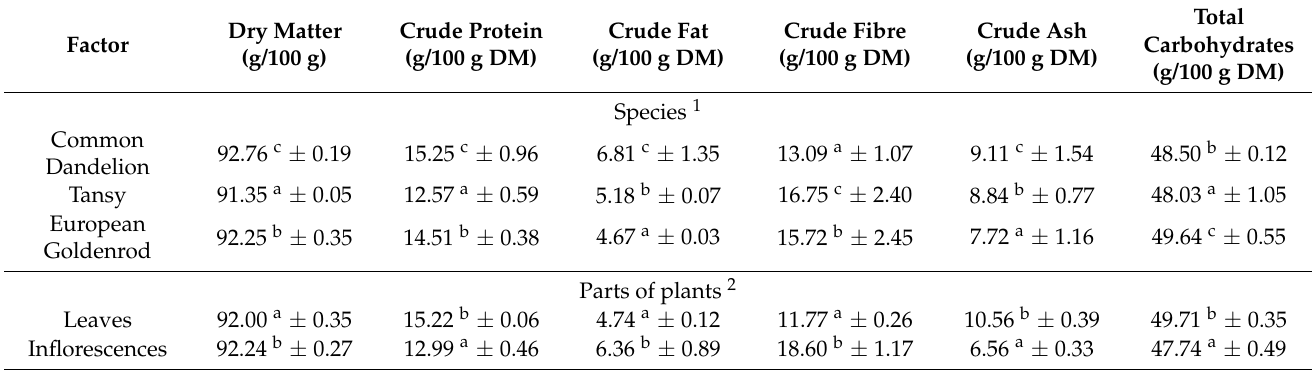
Table 1. The proximate composition of Asteraceae family